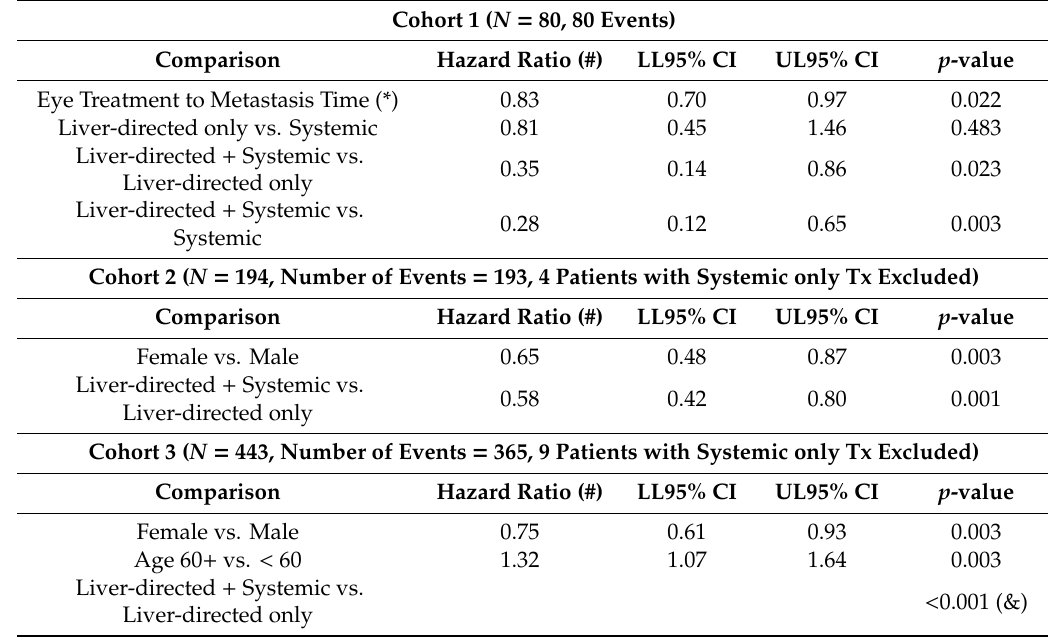
Table 5. Results from the Cox models for overall survival from liver